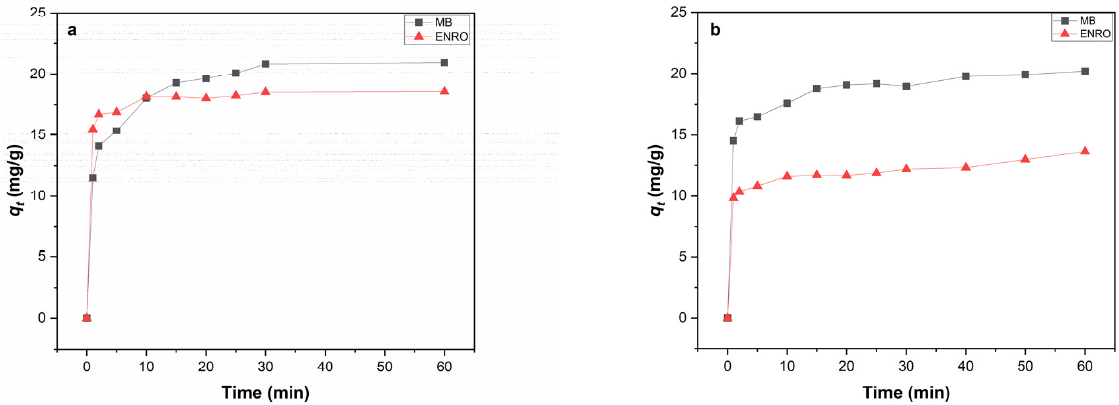
Figure 5. Effect of contact time on the amount adsorbed onto HNC of ( a ) single system, MB and ENRO (C 0 = 40 mg/L, pH = 6.2, C HNC = 2 g/L, T = 28 °C) and ( b ) binary system (C 0 MB = 40 mg/L, C 0 ENRO = 40 mg/L pH = 6.2, C HNC = 2 g/L, T = 28 °C).